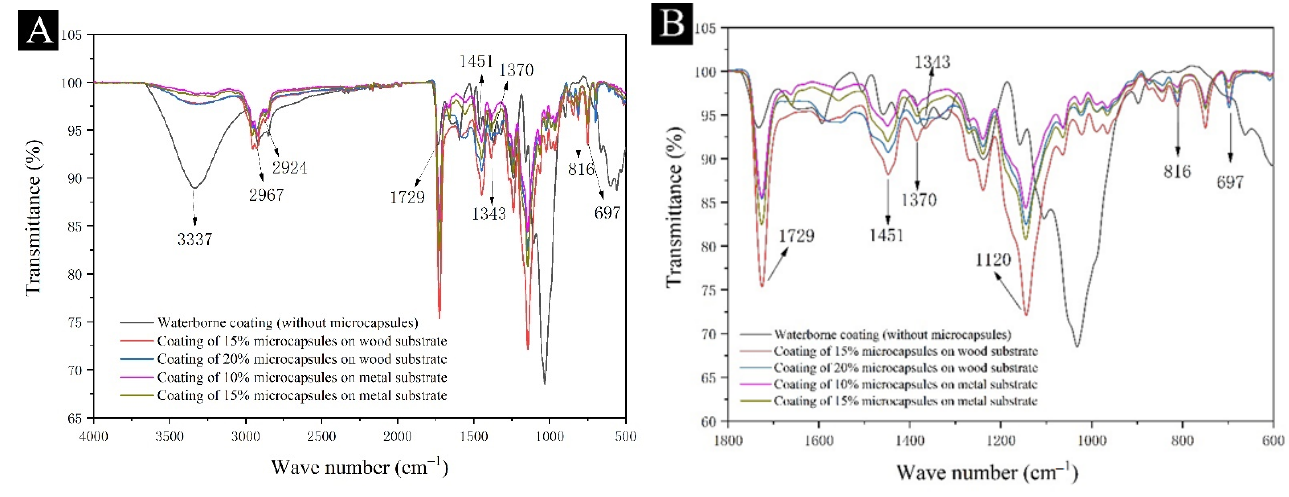
Figure 6. FTIR image of the coatings: ( A ) wave number at 500–4000 cm − 1 , ( B ) wave number at 600–1800 cm − 1 .